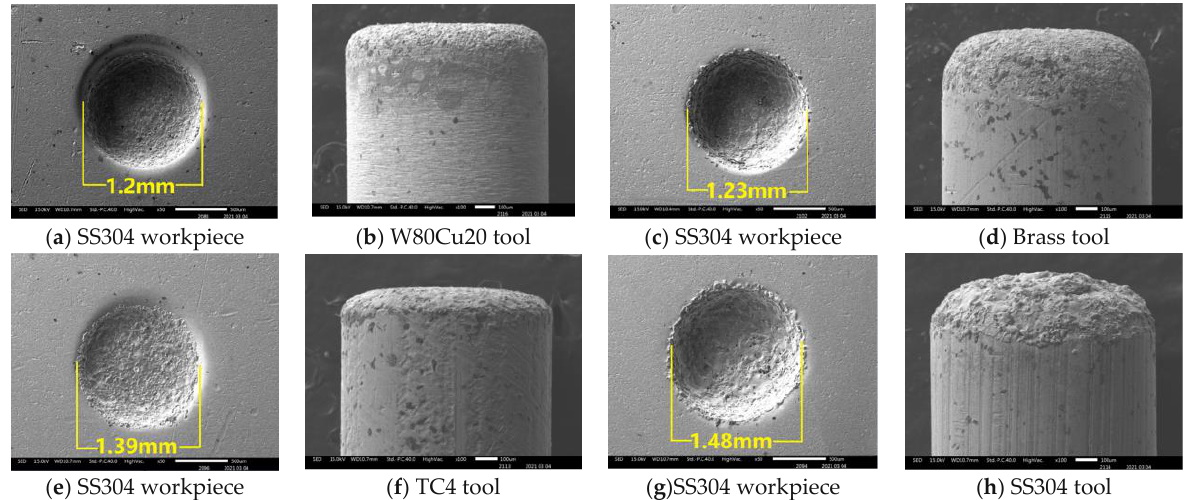
Figure 7. SEM picture of different electrodes and discharging phenomena of the holes on SS304 workpiece under machining conditions Ton = 12 μs, Toff = 12 μs, Ip = 14.17 A.